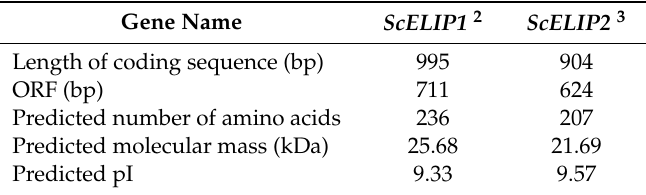
Table 1. Properties of cloned ScELIPs 1